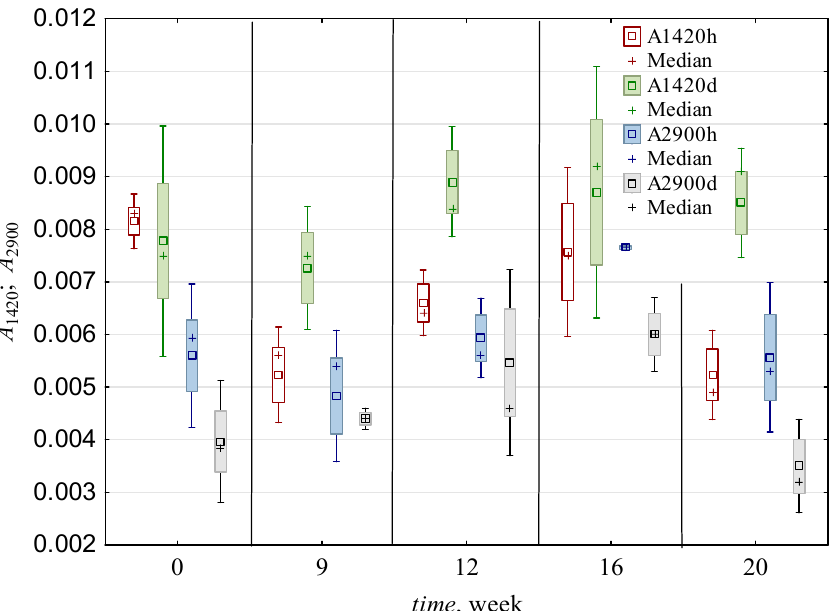
Figure 9. Value of A 1420 absorbance for wavenumbers characteristic of CH 2 bending vibrations related to the crystalline fraction and for A 2900 characteristic for CH 2 stretching vibrations related to the amorphous fraction; h —peak height, d —peak deconvolution, □ —mean, frame— SE , and whisker— SD.